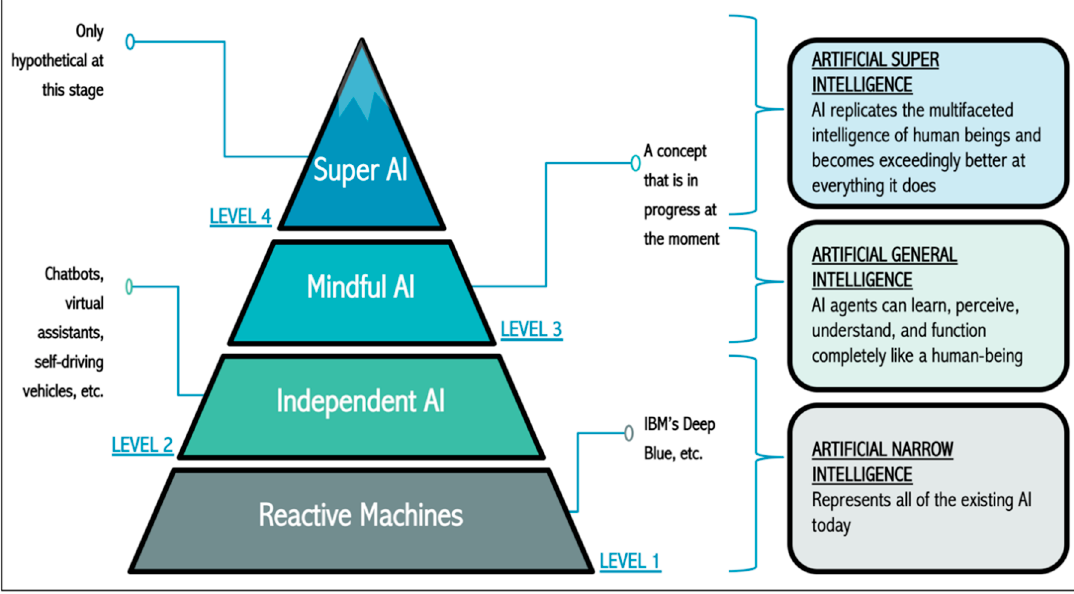
Figure 1. Levels of artificial intelligence, derived from [33].